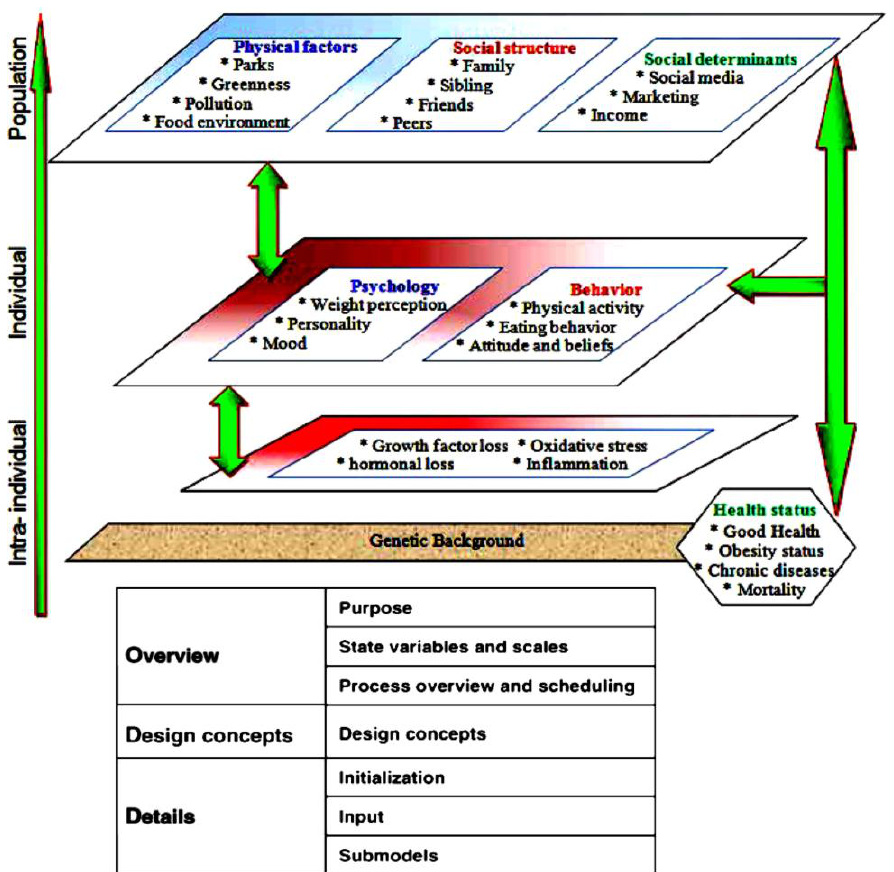
Figure 4. Top: a multi-level classification of obesity factors (adapted from [20]). Bottom: the Overview, Design concepts and Details (ODD) protocol (from [21]).